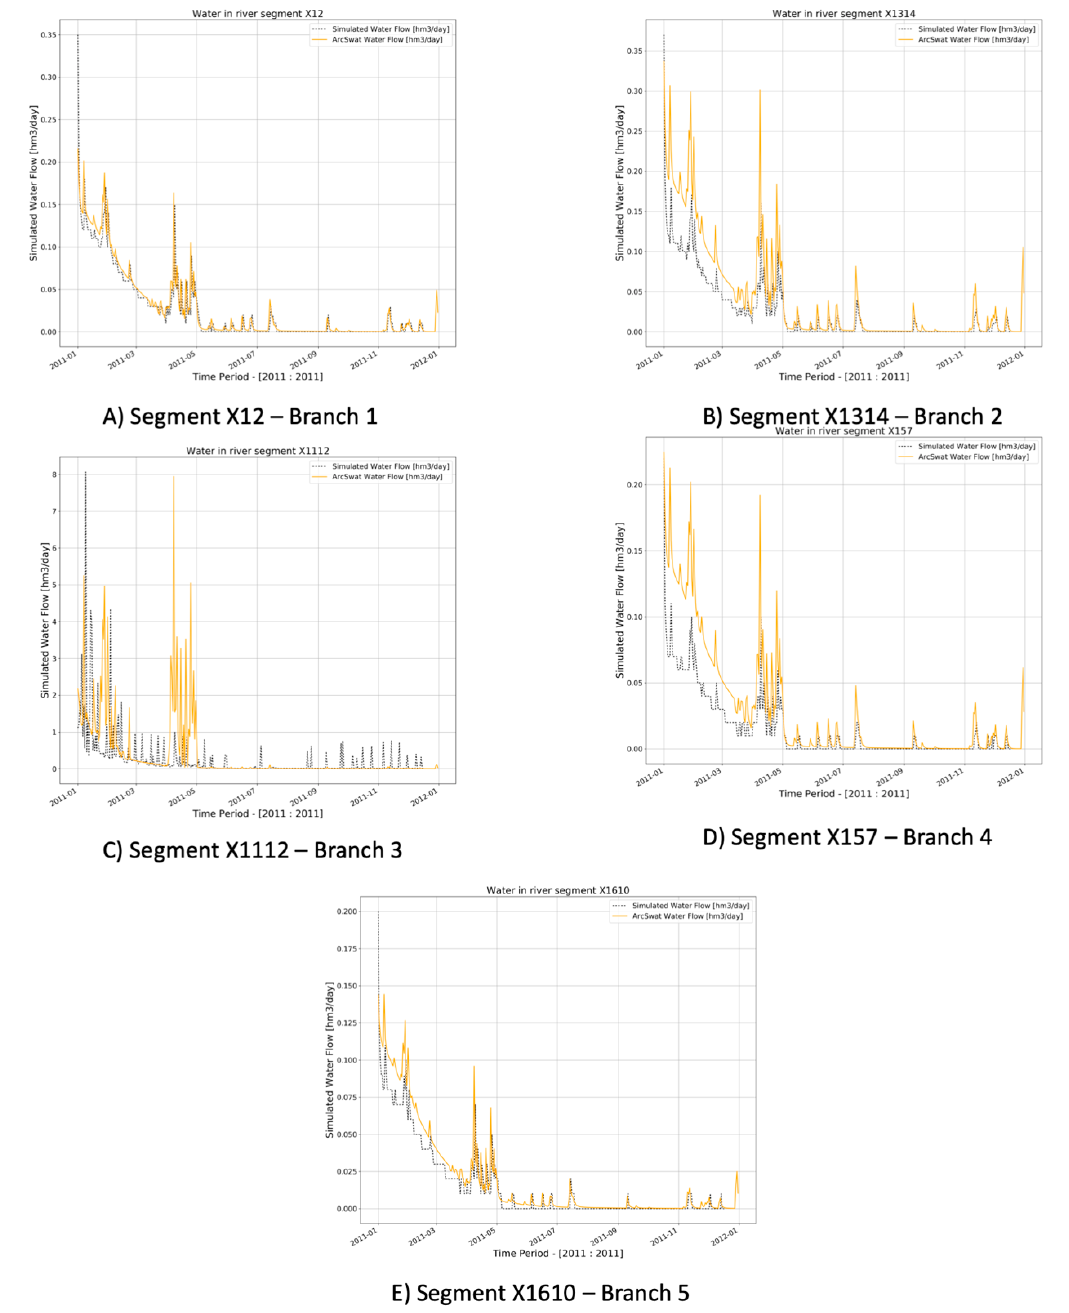
Figure 12. Comparison of the water volume present within the river segments as computed by ArcSWAT with the volumes simulated by the calibrated LP model for the 2010–2011 period.